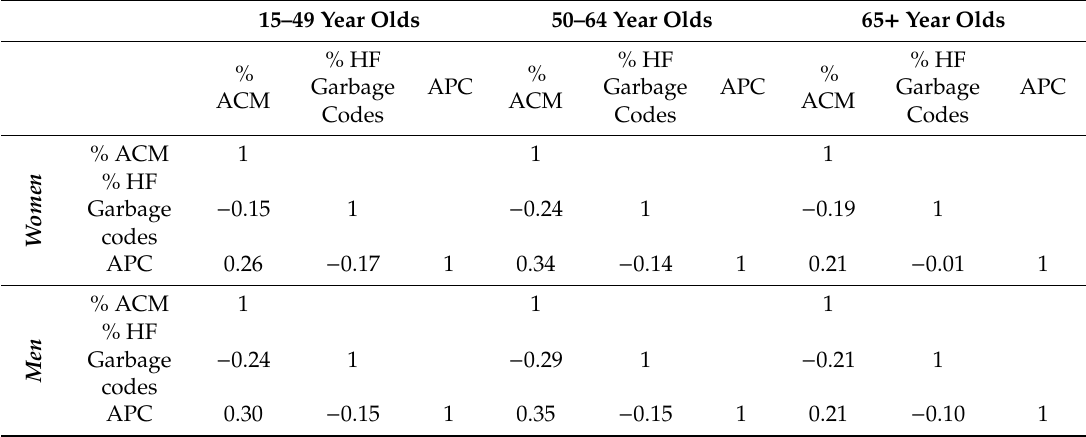
Table A2. Bivariate correlations of % HF garbage codes and % ACM